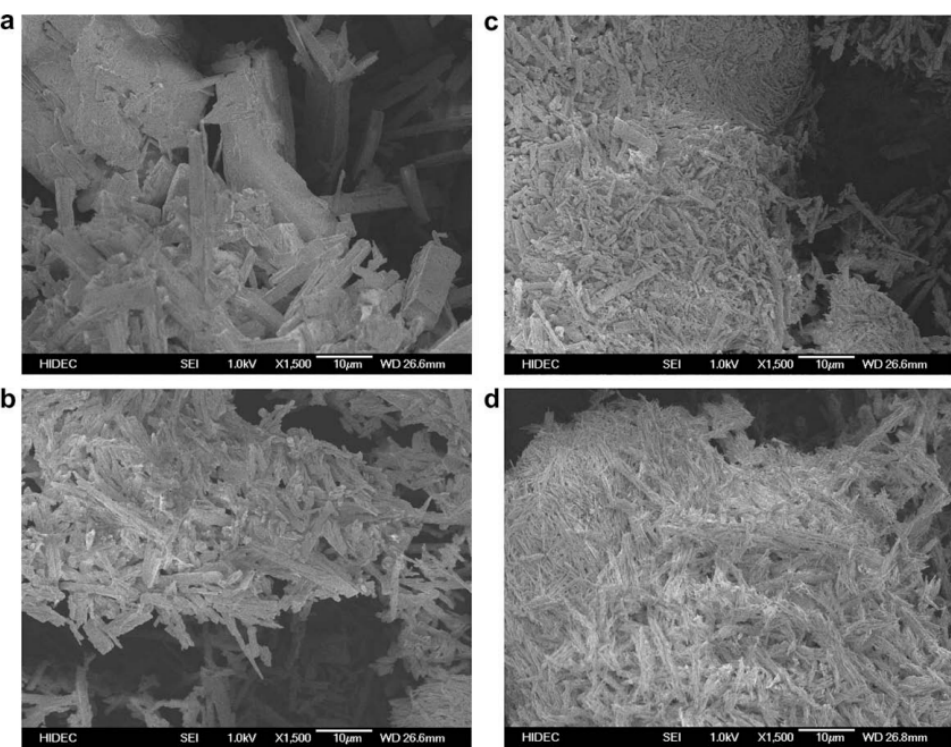
Figure 1. Scanning electron microscopy (SEM) images of anhydrous quercetin at 25 ◦ C ( a ); quercetin dihydrate at 25 ◦ C ( b ); quercetin dihydrate at 80 ◦ C ( c ); and quercetin dihydrate at 140 ◦ C ( d ) [27]. “Reproduced with permission from